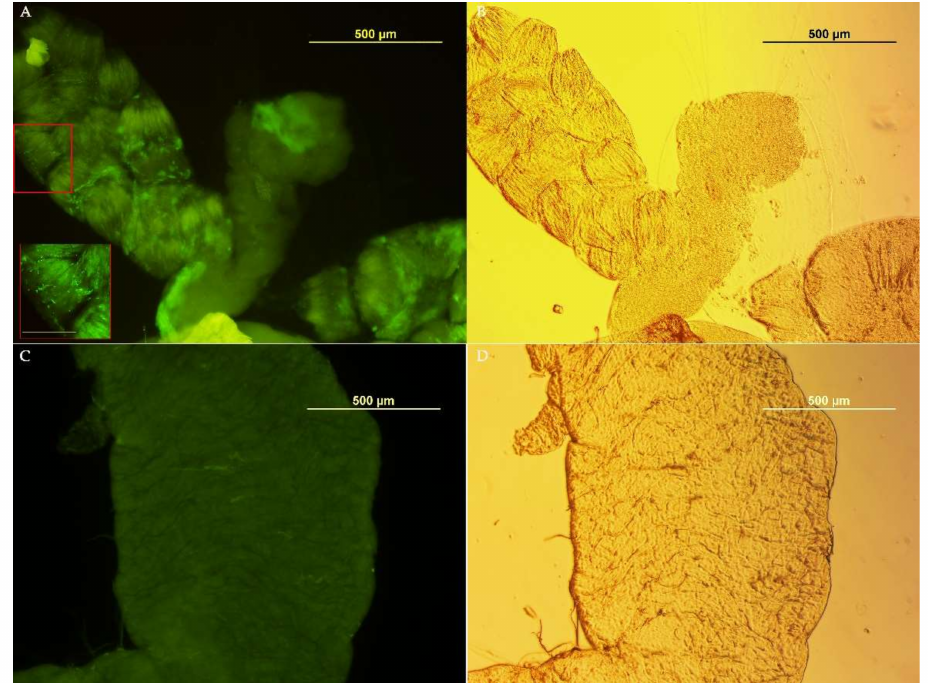
Figure 4. Asaia -GFP detection in C. capitata organs. ( A ) Gut colonized with Asaia -GFP; in the red box, a magnification of a gut portion with green bacteria (bar 50 µ m). ( B ) Phase-contrast image, ( C ) Gut from C. capitata fed on a standard diet (without Asaia ). ( D ) Phase-contrast